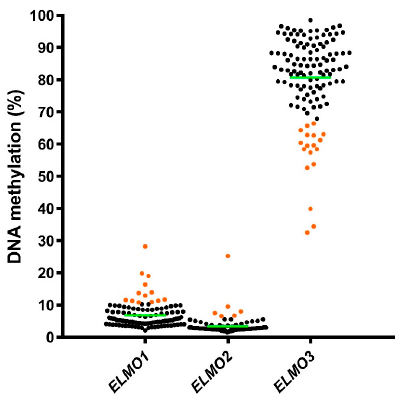
Figure 4. DNA methylation levels in the glioblastoma samples. Hypermethylated cases for ELMO1 and ELMO2 and hypomethylated cases for ELMO3 are indicated in orange color. The green bars indicate mean methylation levels for each gene promoter CpG island.